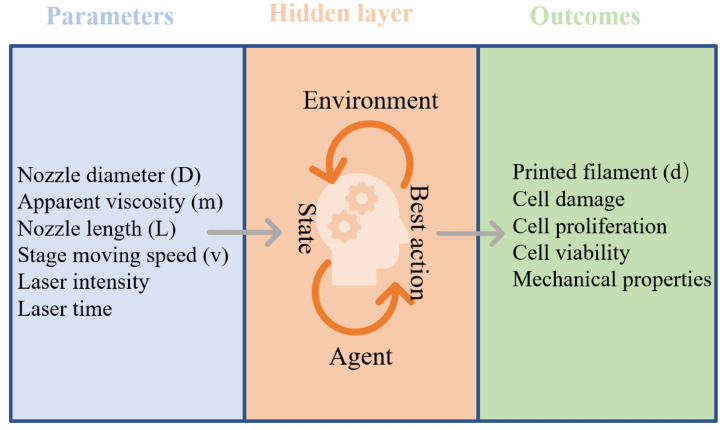
Figure 5. Examples of consideration in bioprinting for a neural network optimization.